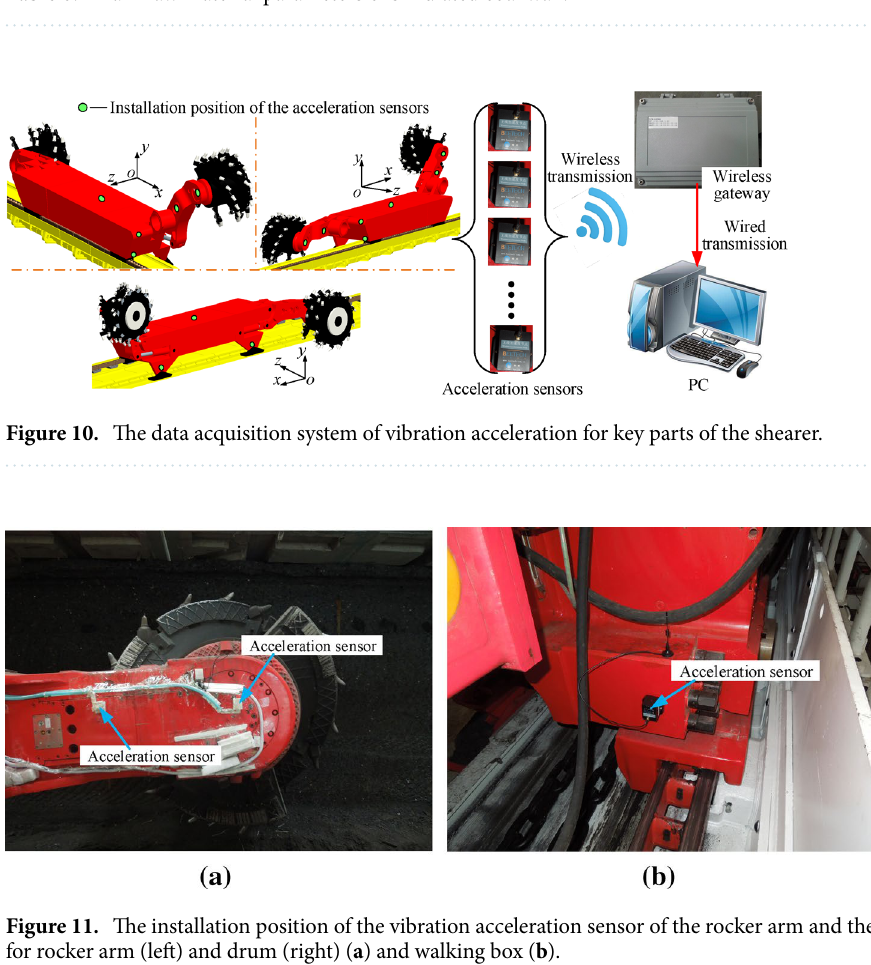
Table 6. Main raw material parameters of simulated coal wall.